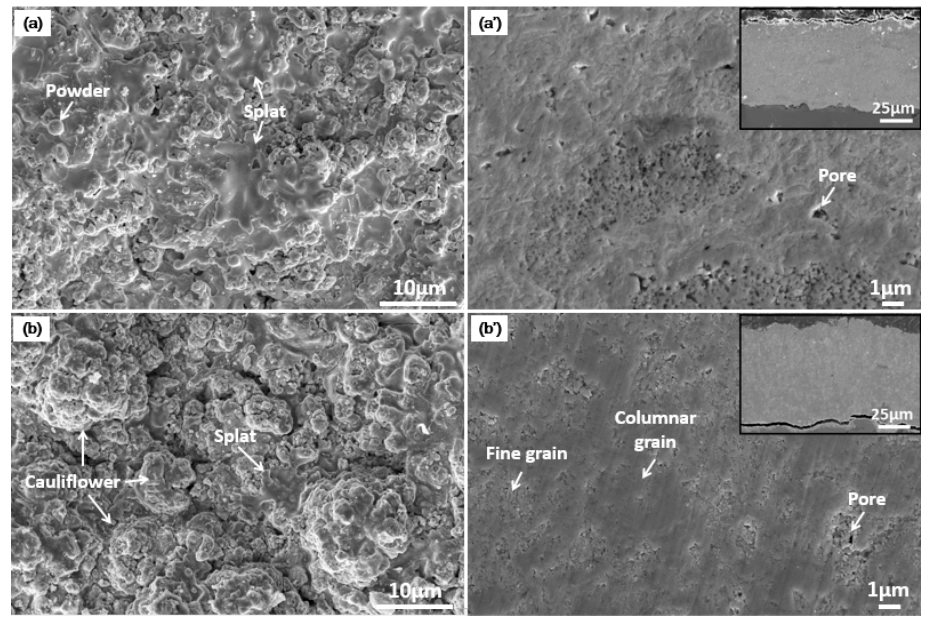
Figure 2. SEM images of GDC coatings: ( a ) surface of VLPPS coating; ( a ´) cross section of VLPPS coating; ( b ) surface of PS-PVD coating; ( b ´) cross section of PS-PVD coating.